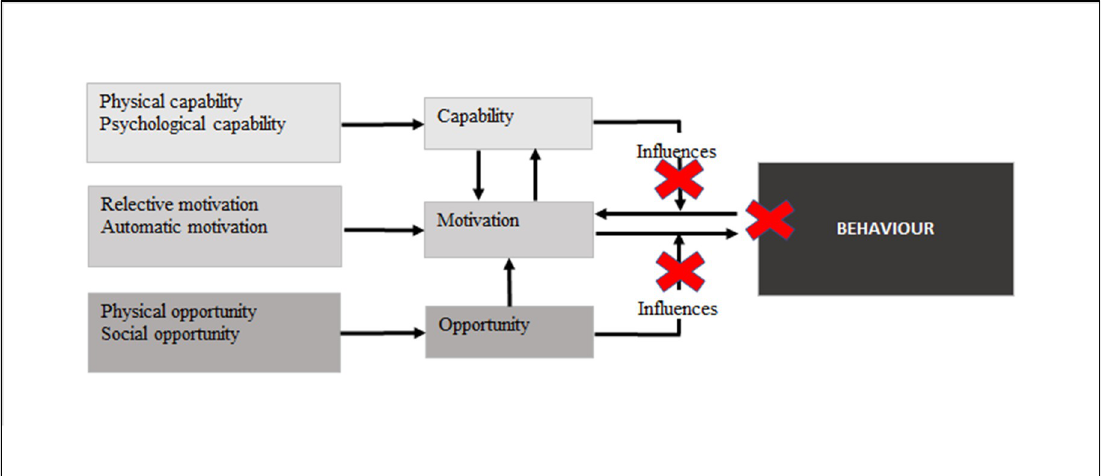
Fig 1. COM-B model: Gates of capability and opportunity adapted from West et al 2020 [32]. Note the crosses represent a barrier to the opening of the gates of capability and opportunity, reducing the chance motivation will lead to behaviour.